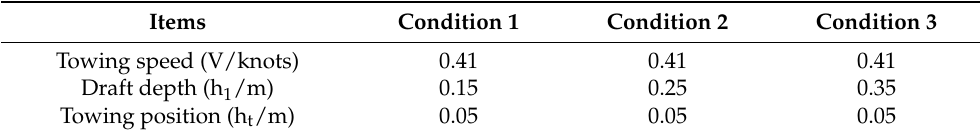
Table 8. Towing conditions of different draft depths. Items